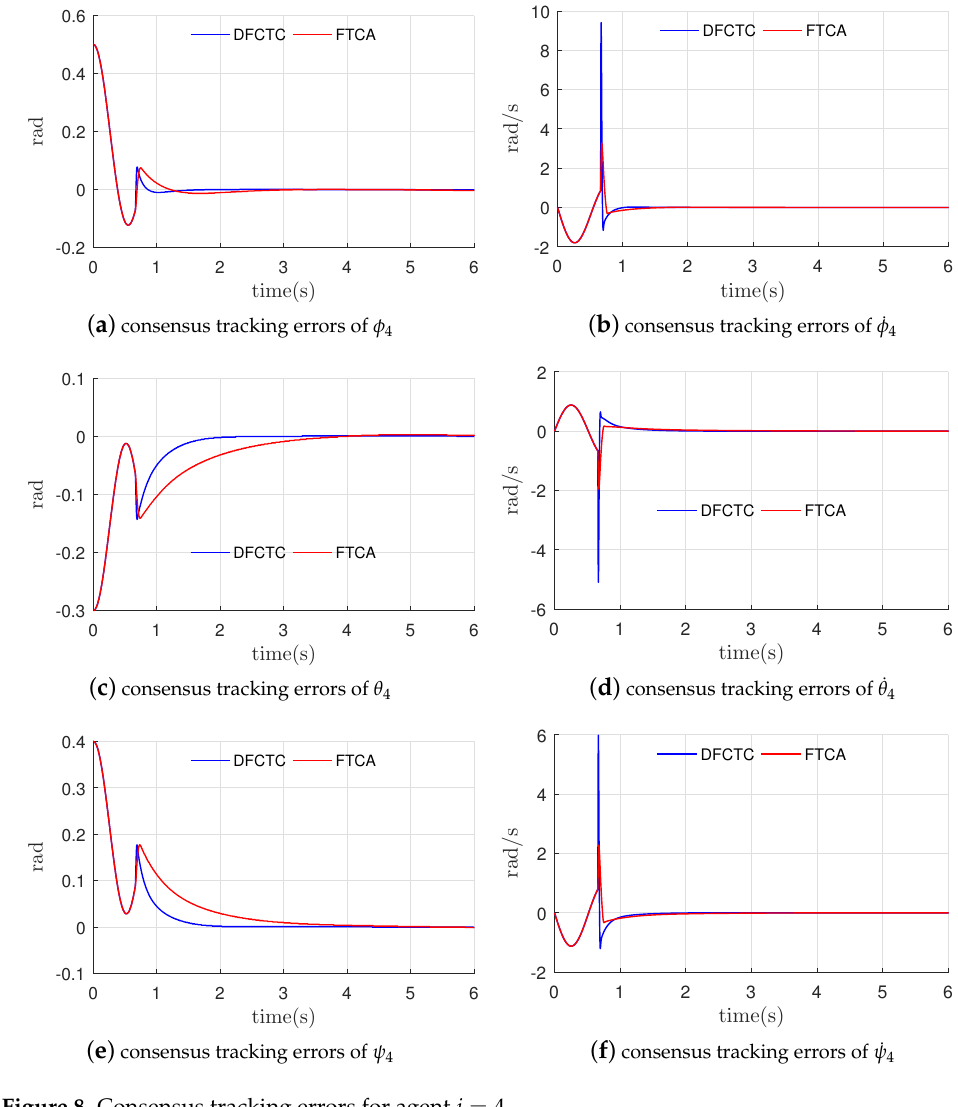
Figure 8. Consensus tracking errors for agent i = 4.